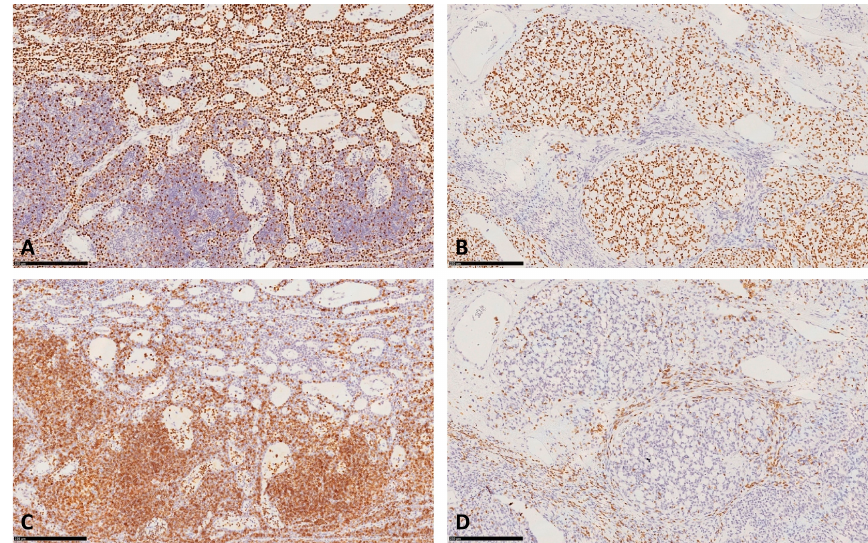
Figure 4. Immunostaining for p63 (15 × ) showing epithelial neoplastic cells positivity in microcystic AB Type Thymoma ( A ) and in microcystic AB Type Thymoma with signet ring-like cells features ( B ); Immunostaining for CD3 (15 × ) showing immature thymic lymphocytes positivity in microcystic AB Type Thymoma ( C ) and in microcystic AB Type Thymoma with signet ring-like cells features ( D ).